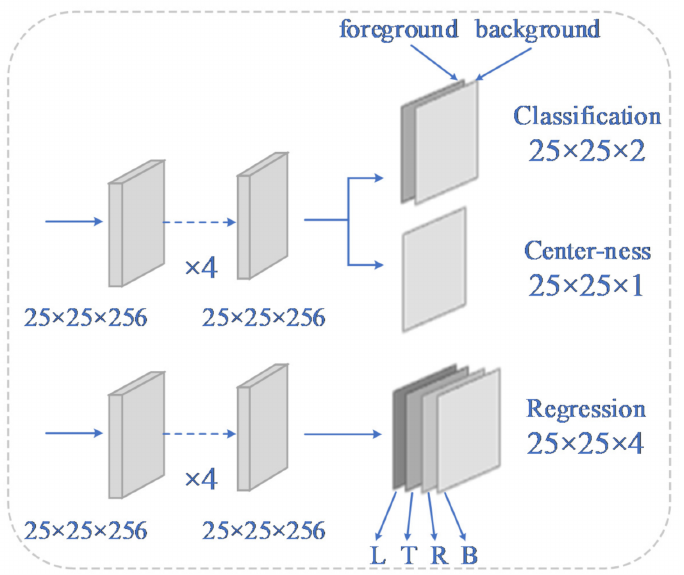
Figure 2. The architecture of the anchor-free network. L, T, R, B represents the distance from this point to the four sides of the bounding box